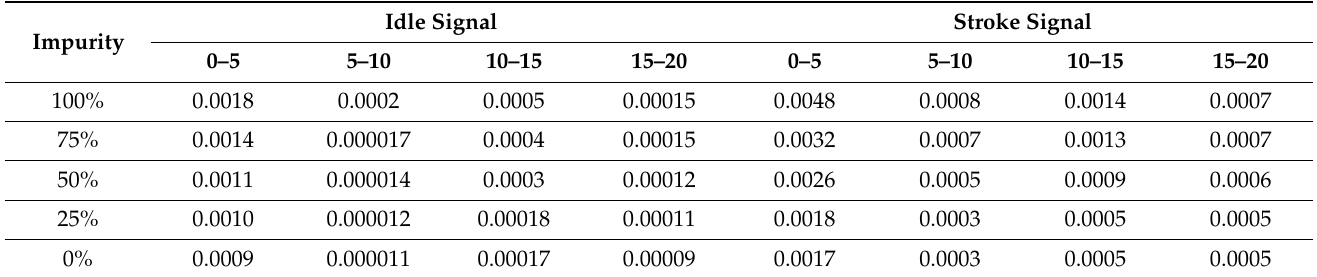
Table 2. Highest frequency amplitudes between 5 kHz steps of Y -axis.